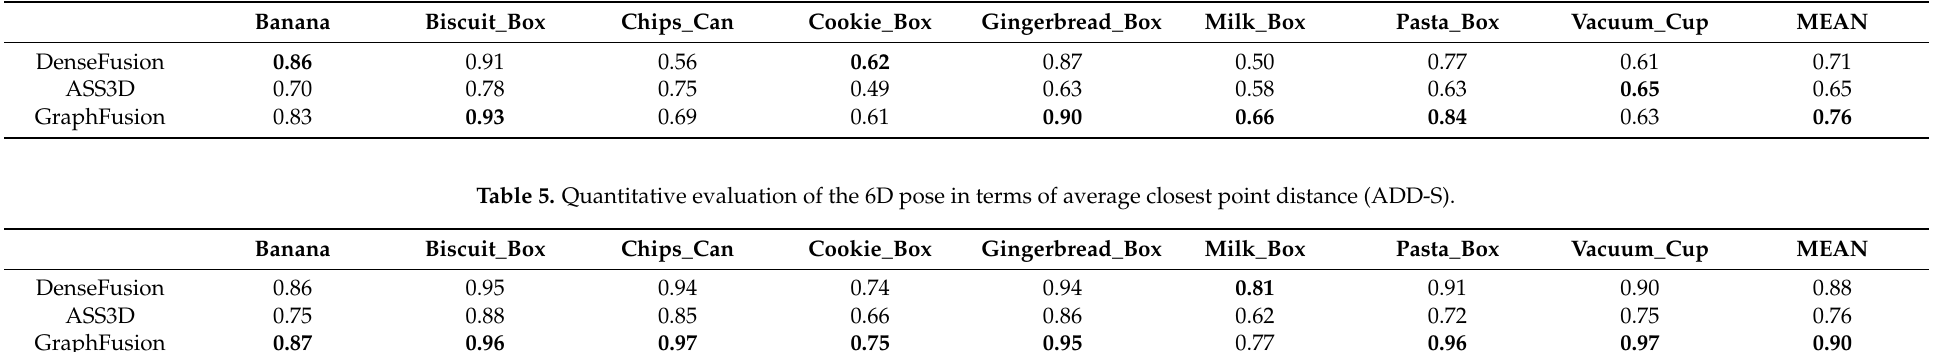
Table 4. Quantitative evaluation of the 6D pose in terms of average distance metric (ADD).